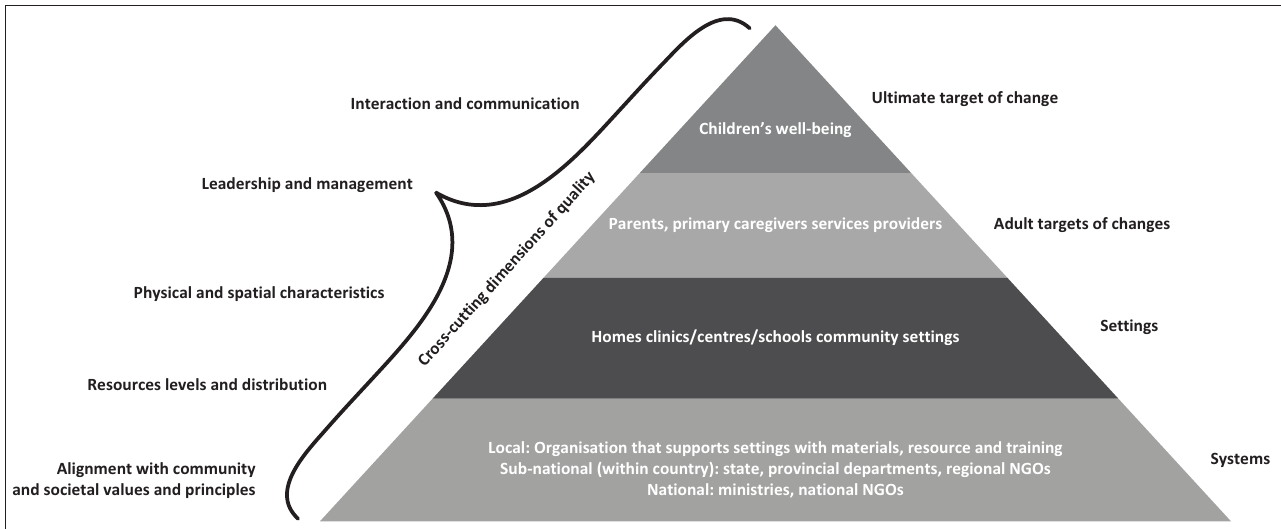
FIGURE 1: Ecological and system-level settings and cross-cutting quality